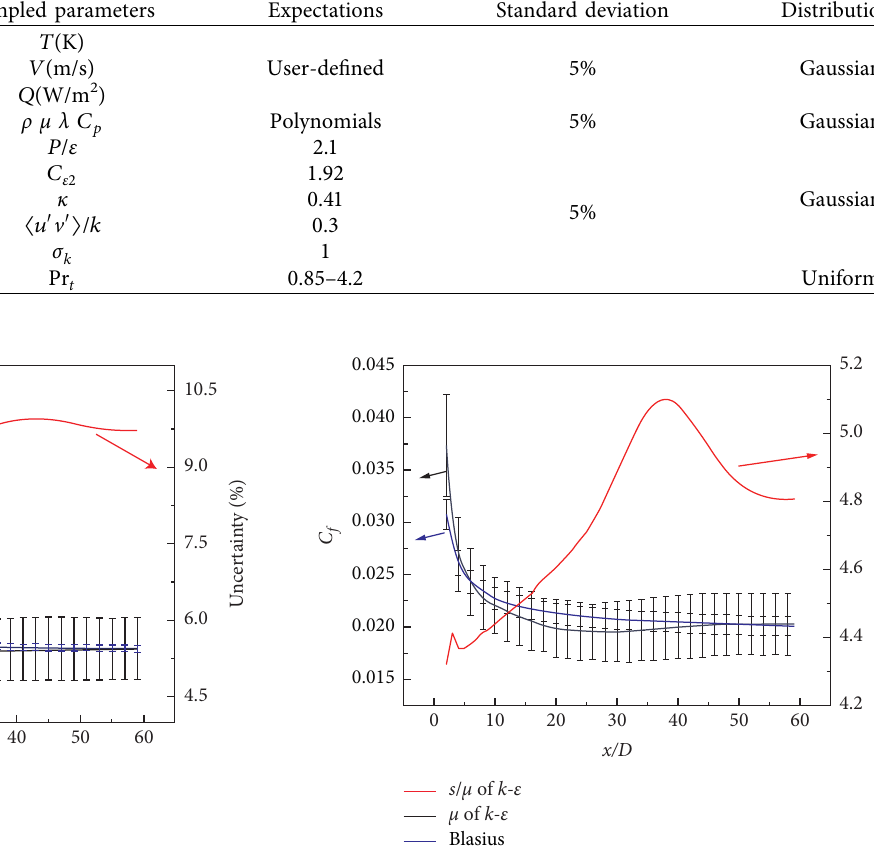
Figure 2: Axial uncertainty quantification of C